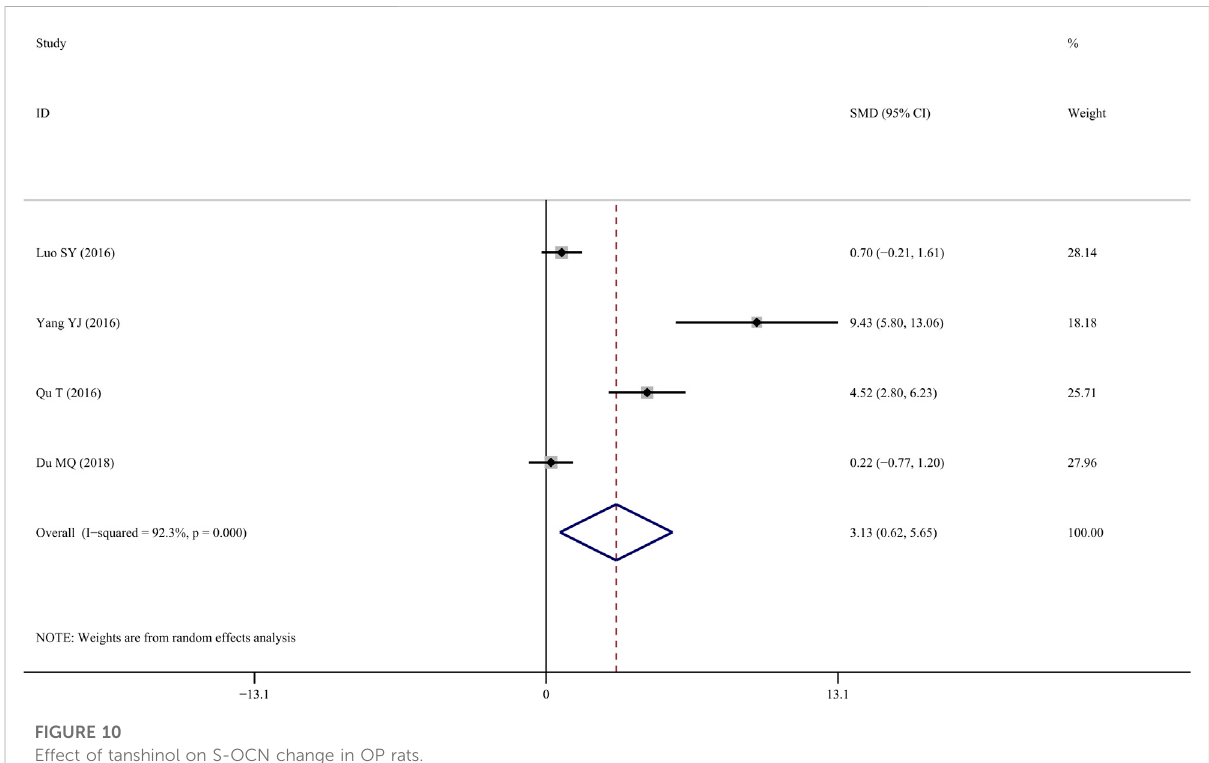
FIGURE 10 Effect of tanshinol on S-OCN change in OP rats.